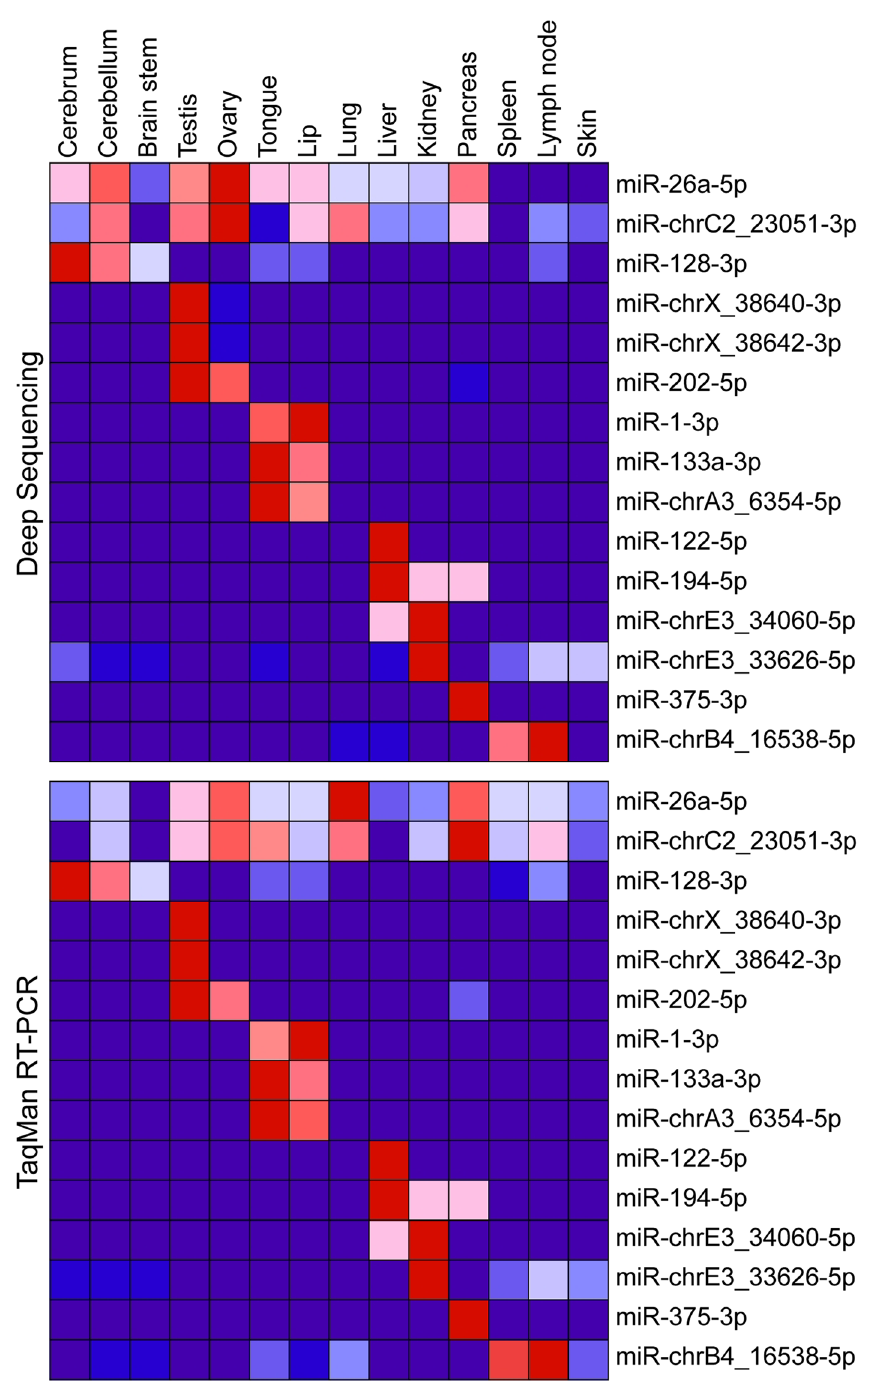
Figure 5. MiRNA validation. Nineteen miRNAs from our deep sequencing data were selected for further validation using real-time TaqMan ® MicroRNA Assays, including nine novel, cat-specific miRNAs. miR-151 and miR-361 were expressed at very consistent levels in all of the deep sequencing samples (not shown) and, thus, qRT-PCR values were normalized to these two miRs. Figure shows heat maps of averaged and normalized miR counts from the deep sequencing data and of the normalized relative expression from qRT-PCR. All of the normalized deep sequencing and qRT-PCR values for each individual miR in each individual sample are given in Supplementary Table